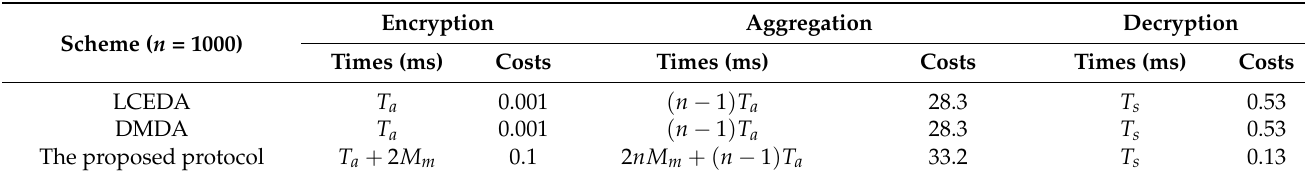
Table 5. Comparisons of computation costs.